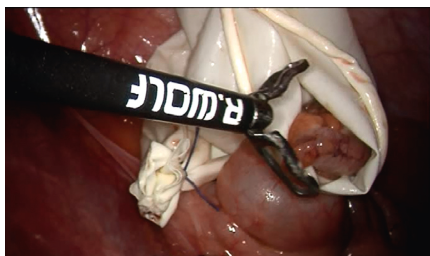
Figure 2: Separation of the appendix.